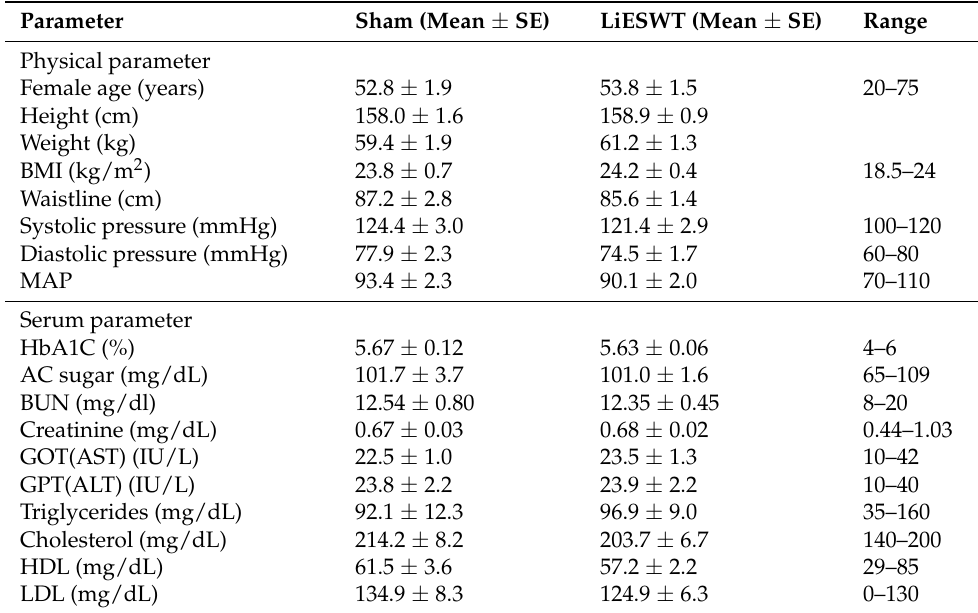
Table 2. Baseline characteristics of stress urinary incontinence (SUI)